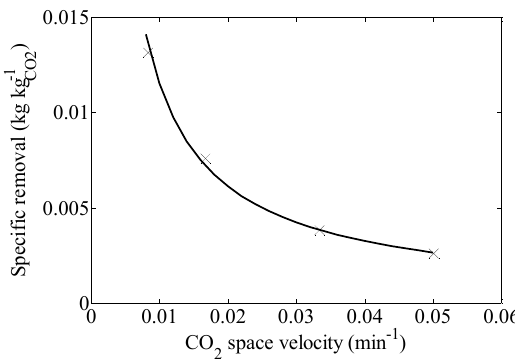
Figure 2. Effect of CO 2 space velocity on specific removal (kg butanol ·kg CO2 − 1 ) at constant pressure (10.34 MPa) and temperature (25 °C).